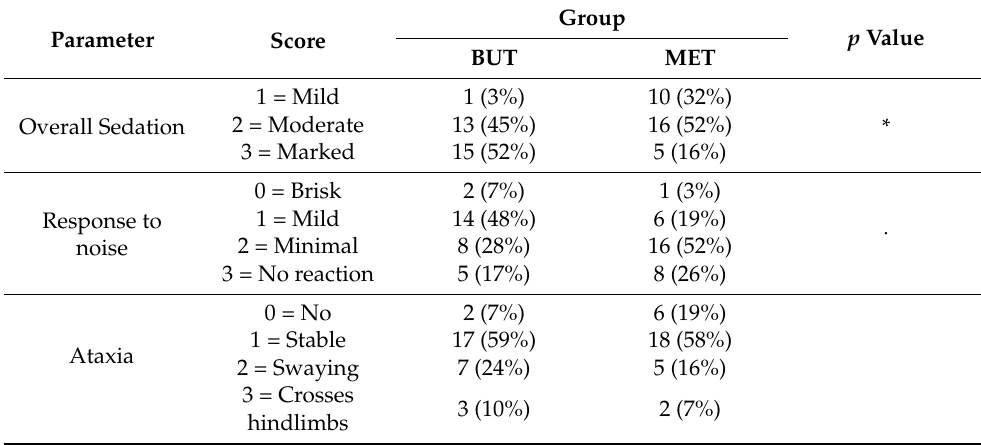
Table 3. Parameters related to the quality of sedation assigned according to the SDS to horses receiving a premedication including romifidine and either butorphanol (group BUT n = 29) or methadone (group MET, n = 31). Values are number and percentages.